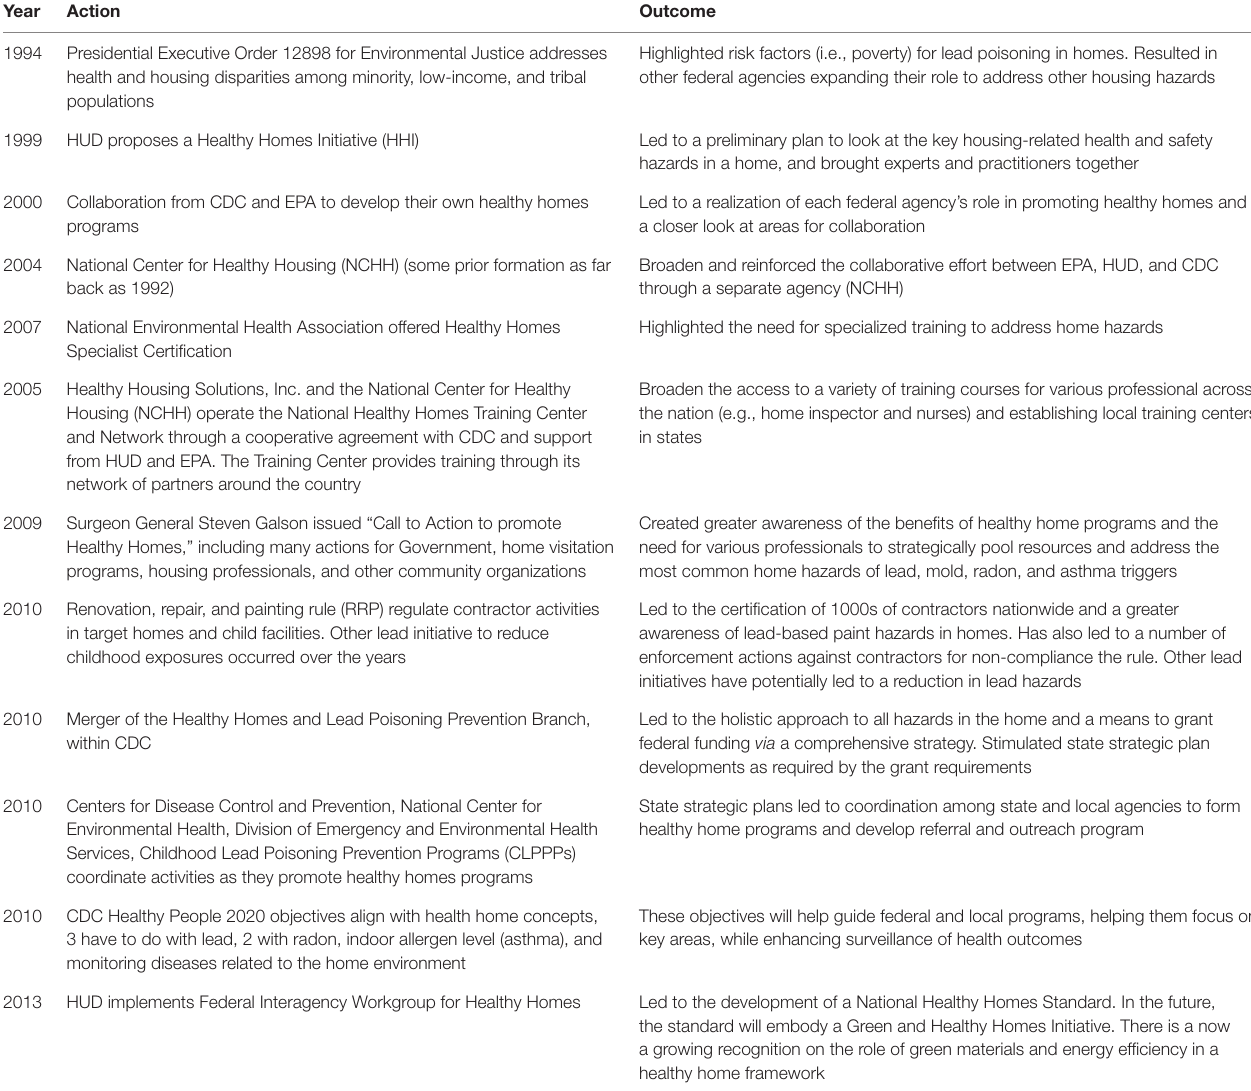
tABLe 1 | specific efforts addressing healthy